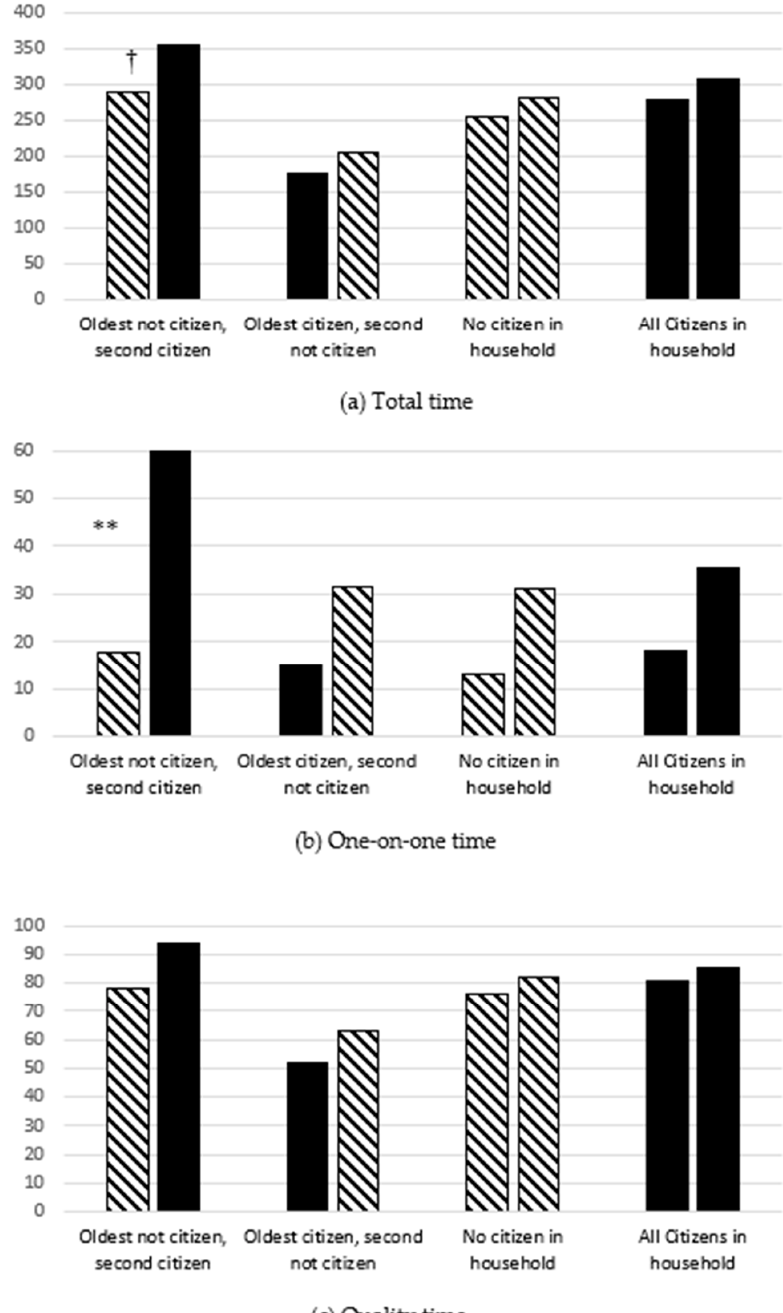
Figure 1. Parental Time Investments in Children by Birth Order and Citizenship Status. Data: American Time Use Survey, 2008–2019. Sample of families with two household children and at least one immigrant parent. For each family type, the oldest child is on the left and the second child is on the right. Dashed bars represent non-citizen children. Black bars represent citizen children. Asterisks (** p < 0.01) and daggers ( † p < 0.10) represent a significant difference in the sibling gap relative to the sibling gap in families with no child with citizenship in the